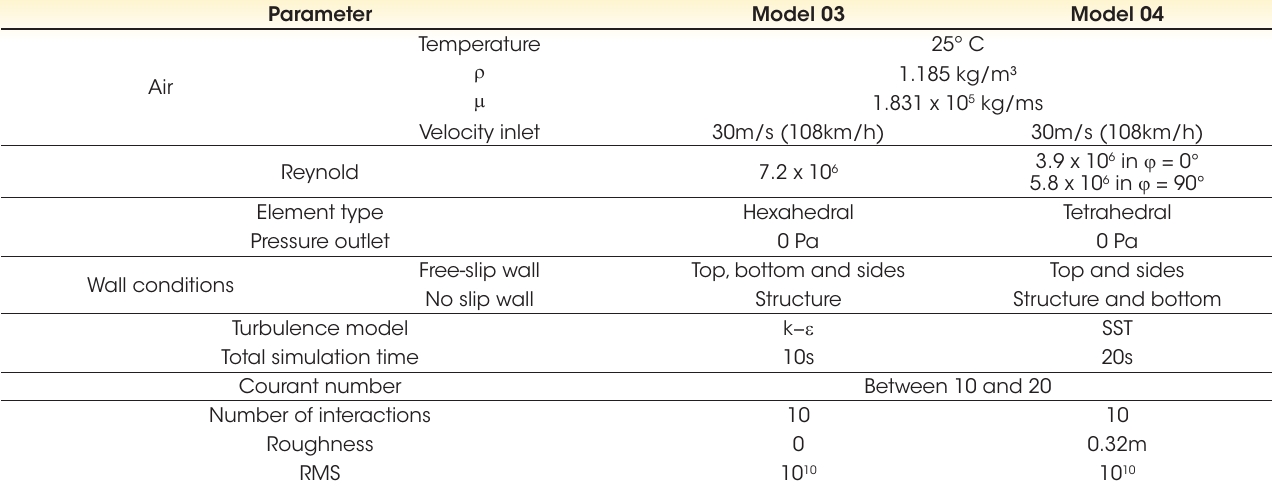
Simulations parameter — aqueduct and